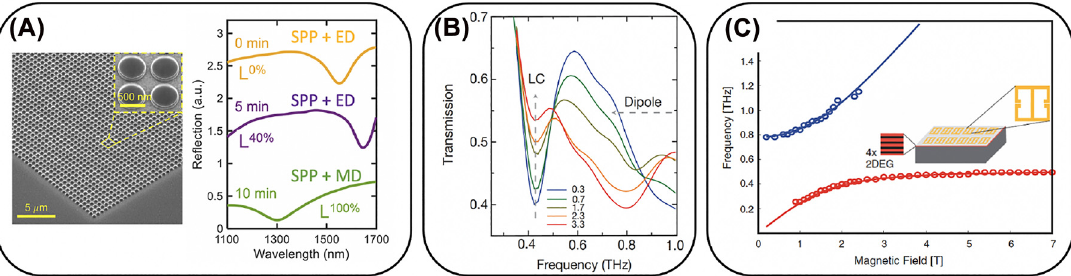
Figure 10: (A) Tilted SEM image of combined Si nanodisk Au plasmonic structure with integrated GST phase change material